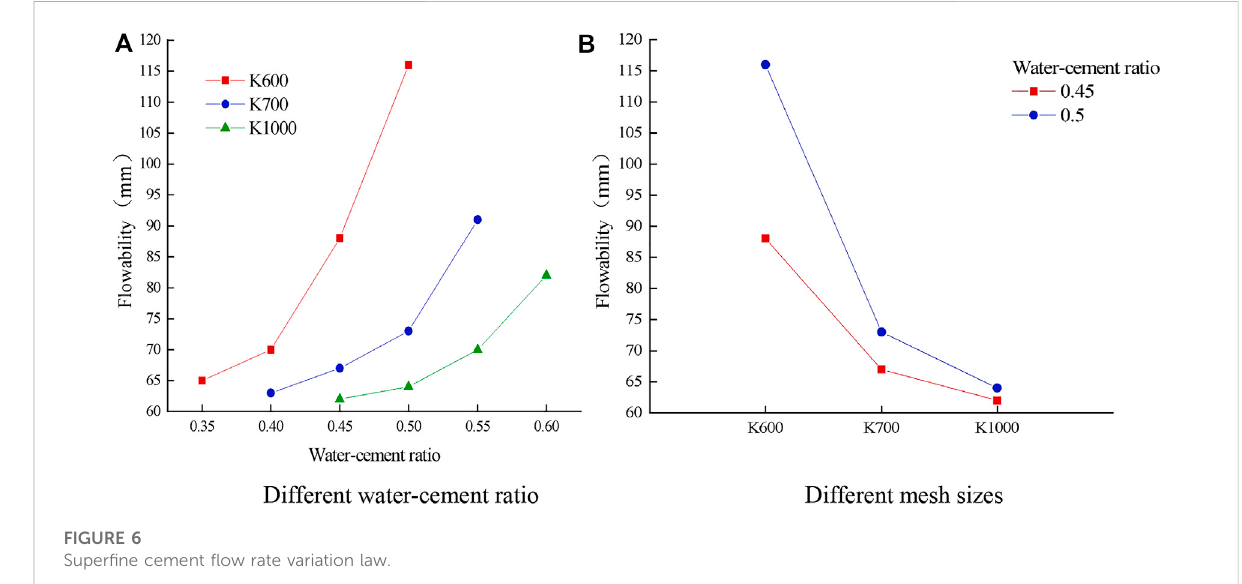
FIGURE 6 Super fi ne cement fl ow rate variation law.